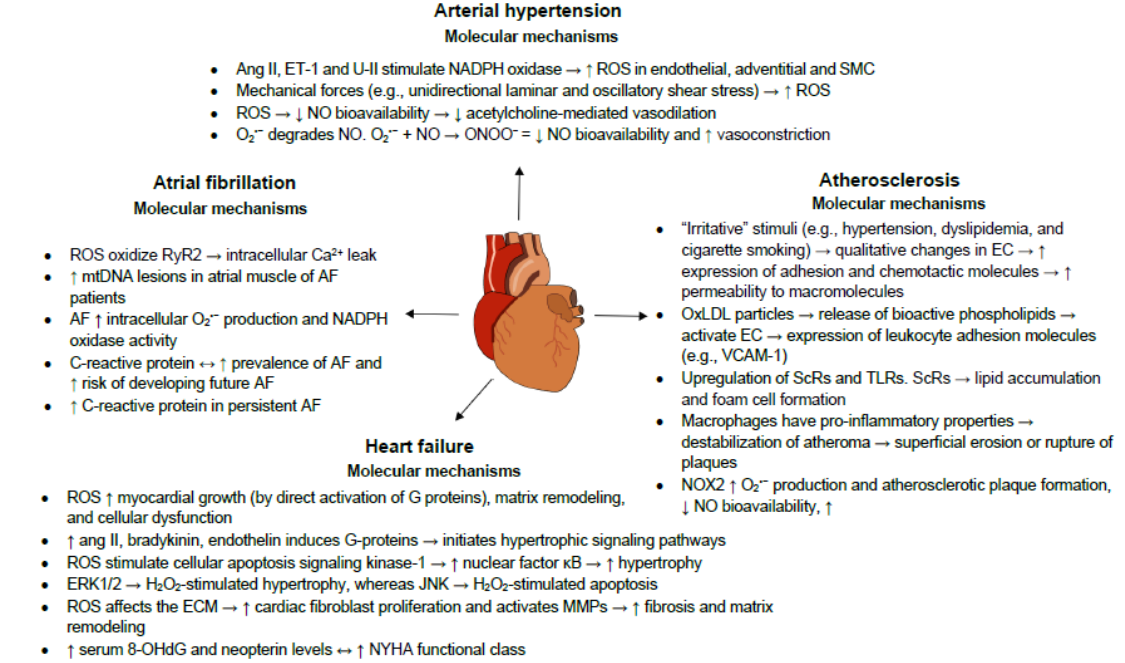
Figure 2. Selected cardiovascular diseases and their underlying oxidative and inflammatory molecular mechanisms. 8-OHdG: 8-hydroxy-2 (cid:48) -deoxyguanosine AF: atrial fibrillation; Ang II: angiotensin II; EC: endothelial cells; ECM: extracellular matrix; ERK 1 / 2: extracellular signal-regulated kinase 1 / 2; ET-1: endothelin 1; H 2 O 2: hydrogen peroxide; JNK: c-Jun N-terminal kinase; MMP: matrix